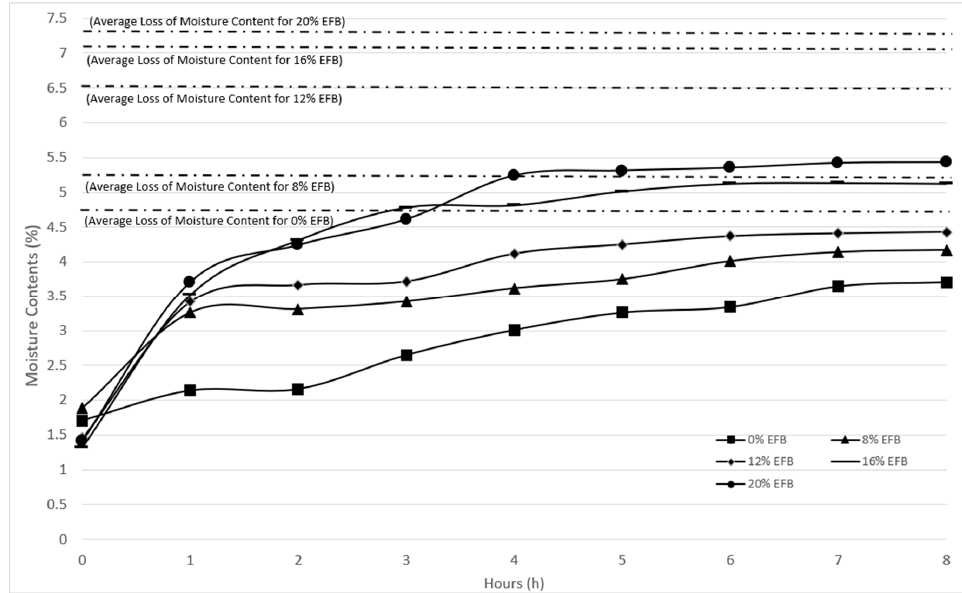
Figure 6. Moisture uptake analysis and average loss of moisture contents for EFB composites.